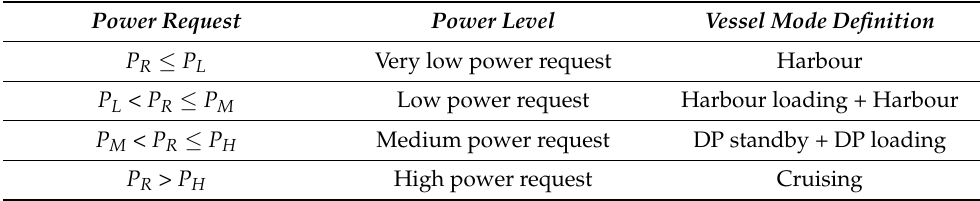
Table 4. Power level and vessel switching mode